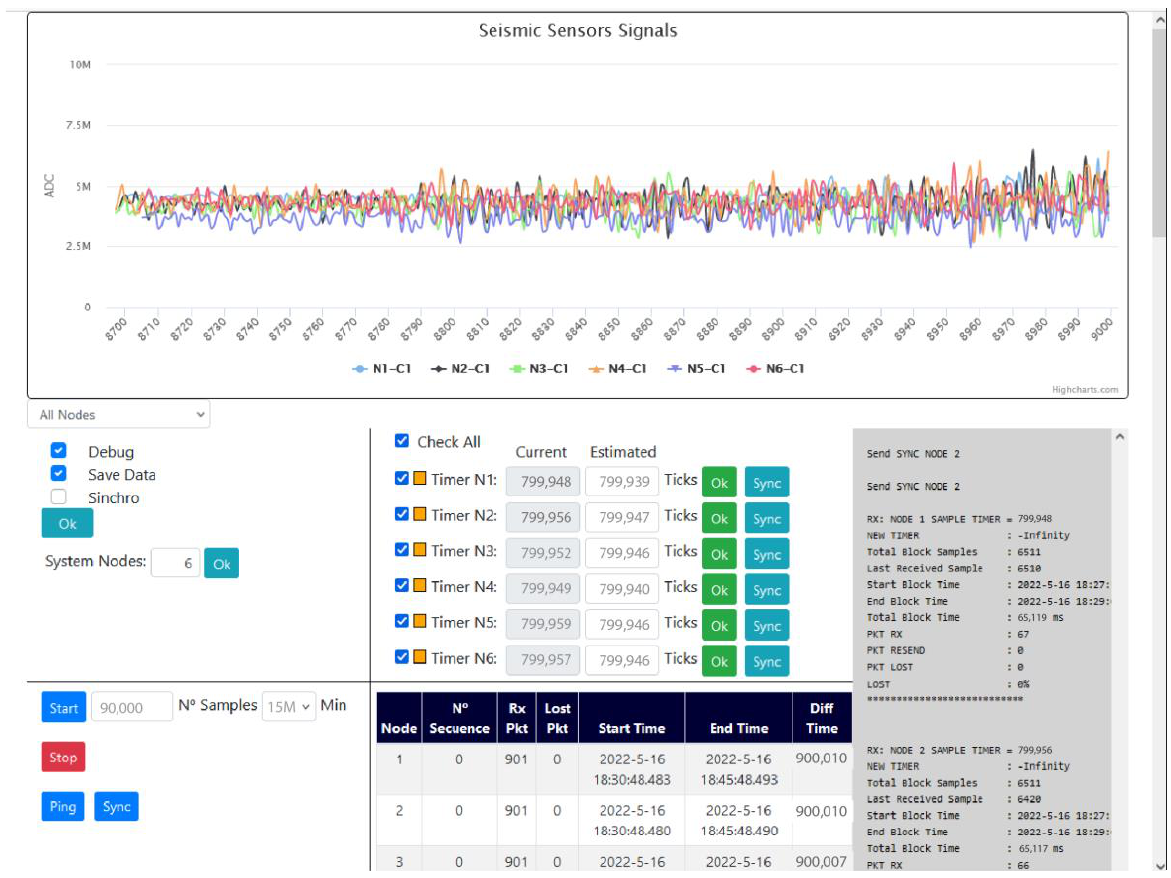
Figure 7. User interface of the Web client.